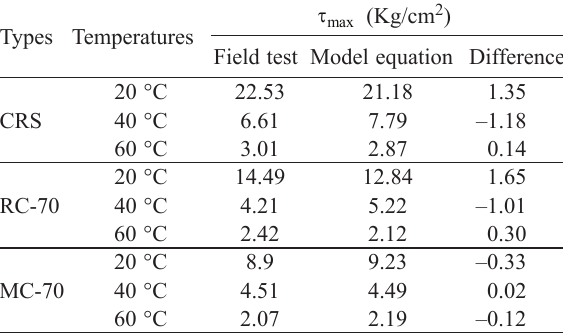
Table 6. Shear stress from field test and model